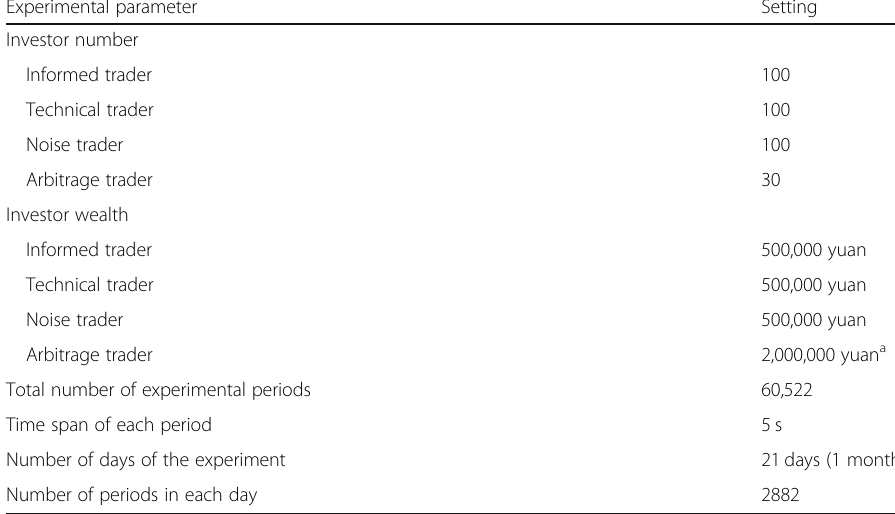
Table 1 Experimental parameter settings Experimental parameter